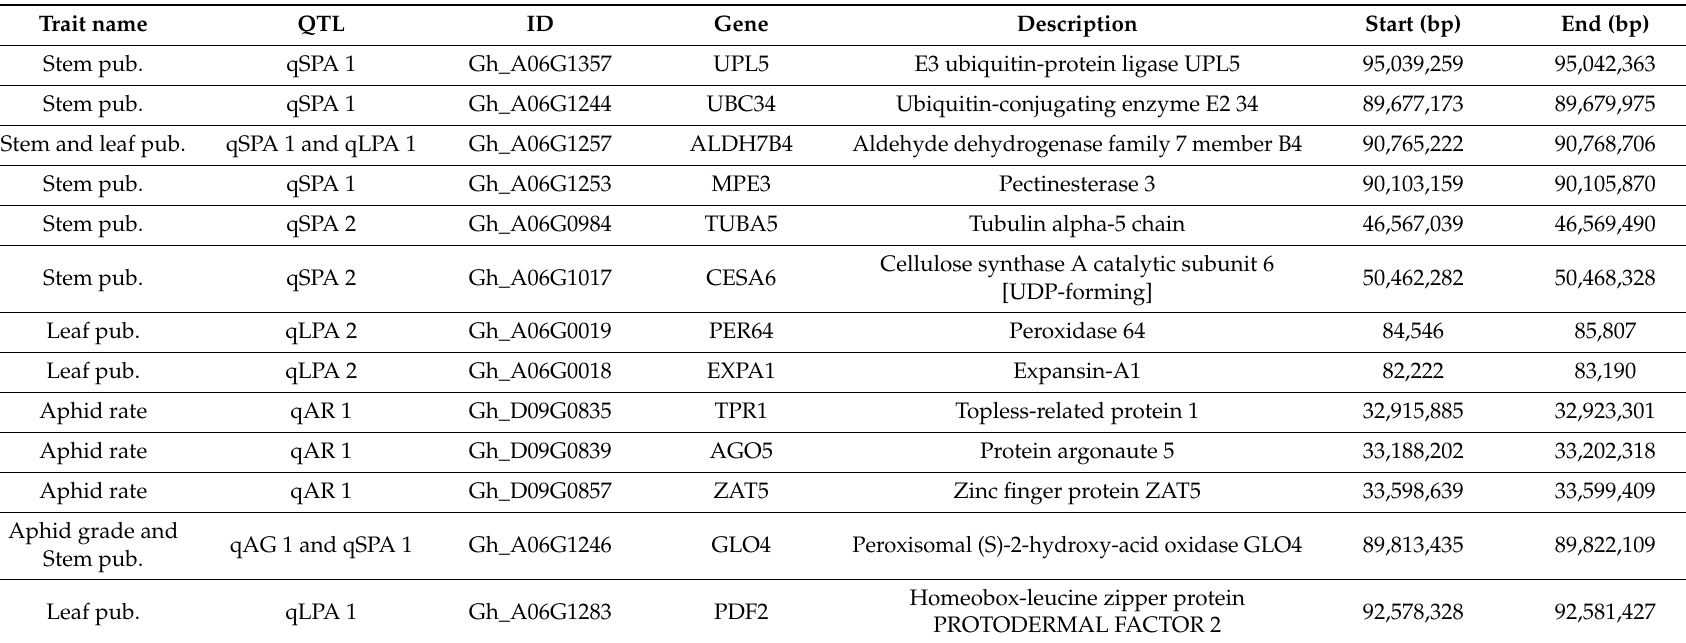
Table 4. List of candidate genes related to plant trichomes and response of plant against pests